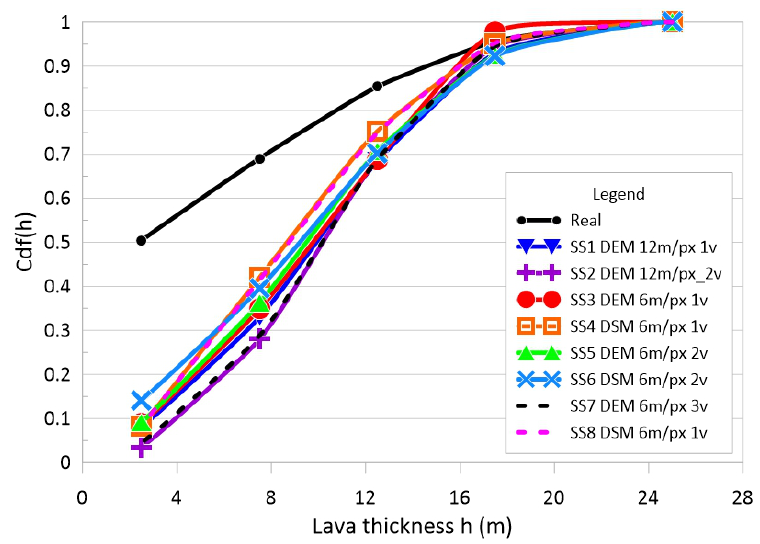
Figure 4. Cumulative frequency function for the lava flow thickness obtained on 25 September from real data (Cabildo Insular de La Palma) and simulations (Table 2) performed up to that